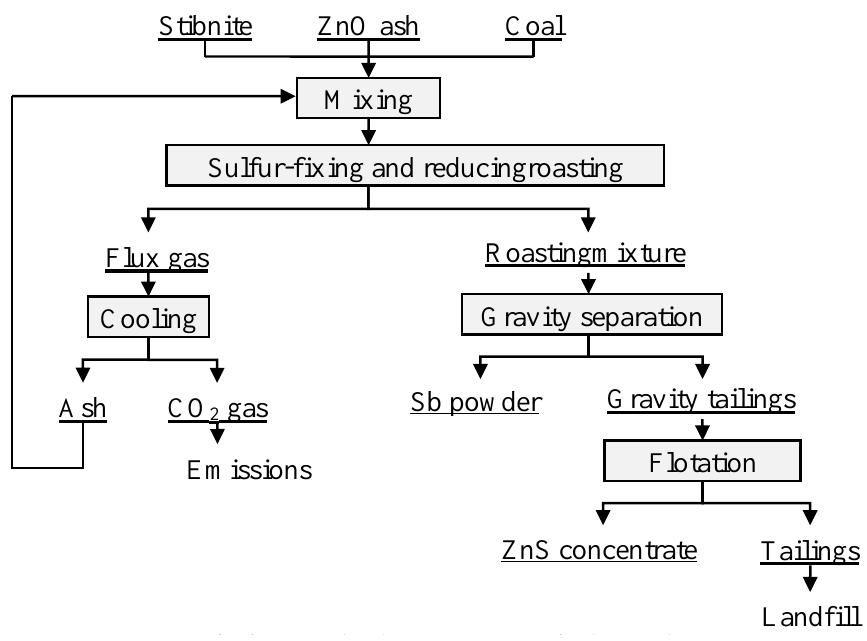
Figure 2. Process of S-fixing and reduction roasting of stibnite (Sb 2 S 3 ).